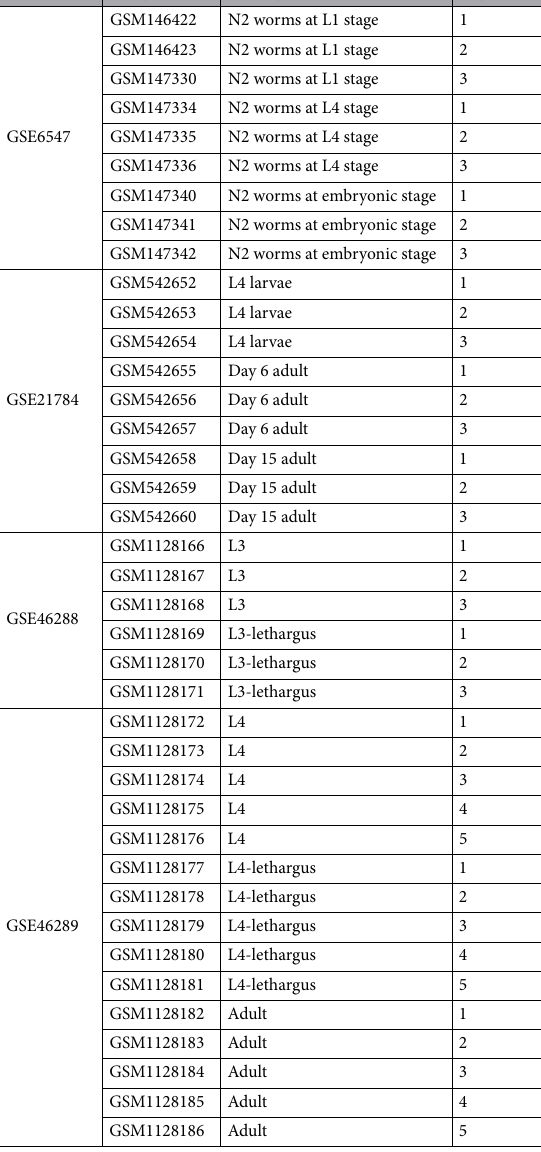
Table 4. Experiments used for the analysis of the developmental time line of C. elegans , obtained from the GEO expression data